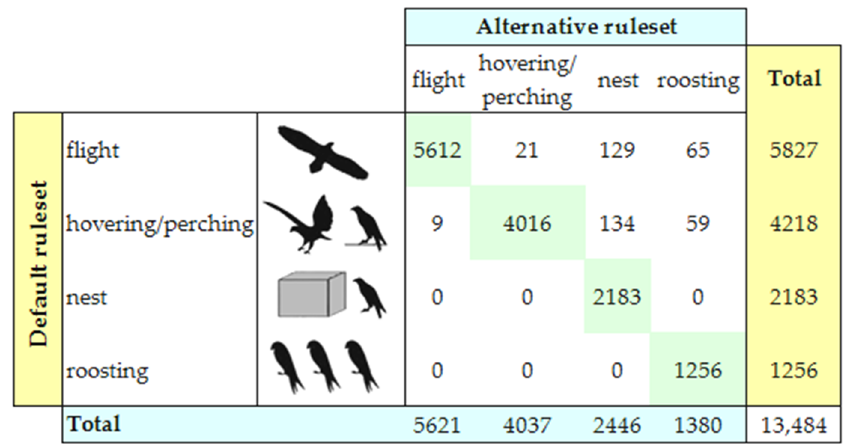
Figure 2. Sensitivity analysis. Rows report the number of GPS points labelled in each behavioral class by using the default threshold ruleset, and columns report the number of GPS points labelled in each behavioral class by using the alternative threshold ruleset. The percentage of GPS points on the diagonal measures the robustness of our GPS data labelling.